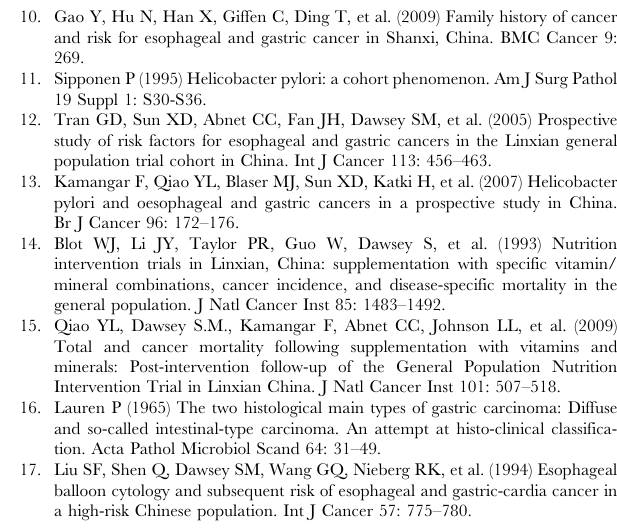
Table S3 Summary of 128 genes that are significantly differentially expressed in GCA only. Table S4 Summary of 144 genes that are significantly differentially expressed in GNCA only. Table S5 Genes significantly associated with patient’s personal/ clinical characteristics for GCA ( Table S5a: Genes related to family history of UGI cancer in GCA cases; Table S5b: Genes related to lymph node metastasis in GCA cases). Table S6 Genes significantly associated with patient’s personal/ clinical characteristics for GNCA ( Table S6a: Genes related to family history of UGI cancer in GNCA cases; Table S6b: Genes related to tumor stage in GNCA cases; Table 6Sc: Genes related to tumor grade in GNCA cases; Table S6d: Genes related to metastasis in GNCA cases). Table S7 Comparison of gene expression for 12 genes in 41 GCA patients studied using both microarray and qRT-PCR. Table S8 Comparison of gene expression for 9 genes in 50 GNCA patients studied using both microarray and qRT-PCR ( Table S8a ). Results of gene expression by qRT-PCR for 9 genes in 44 new GNCA cases ( Table S8b